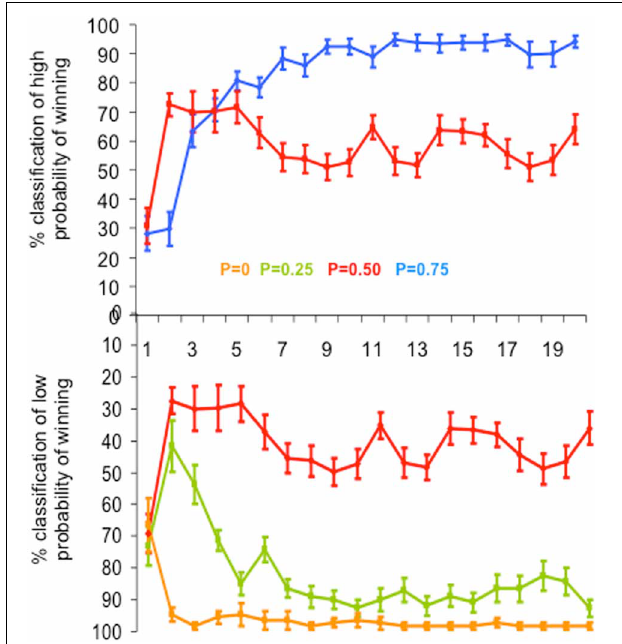
FIGURE 2 | Behavioral performance. Mean learning curves averaged across subjects, expressed as the mean percentage of “high probability of winning” (top) and “low probability of winning” (bottom) estimations of the four slot machines, as a function of trial rank. Vertical bars represent standard errors of the mean. Each slot machine is color coded (with reward probability from 0 to 0.75). Note that the subjects’ task was simply to estimate at each trial the reward probability of each slot machine at the time of its presentation, based upon all the previous outcomes of the slot machine until this trial (i.e., estimate of cumulative probability since the first trial). To do so, subjects had to press one of two response-buttons: “high winning probability” and “low winning probability.” In particular, the estimation of the slot machine with P = 0 . 5 of winning reached the learning criterion (i.e., > 80% correct estimations) after the 7th trial (estimations oscillating around 50% as “high” or “low” probability of